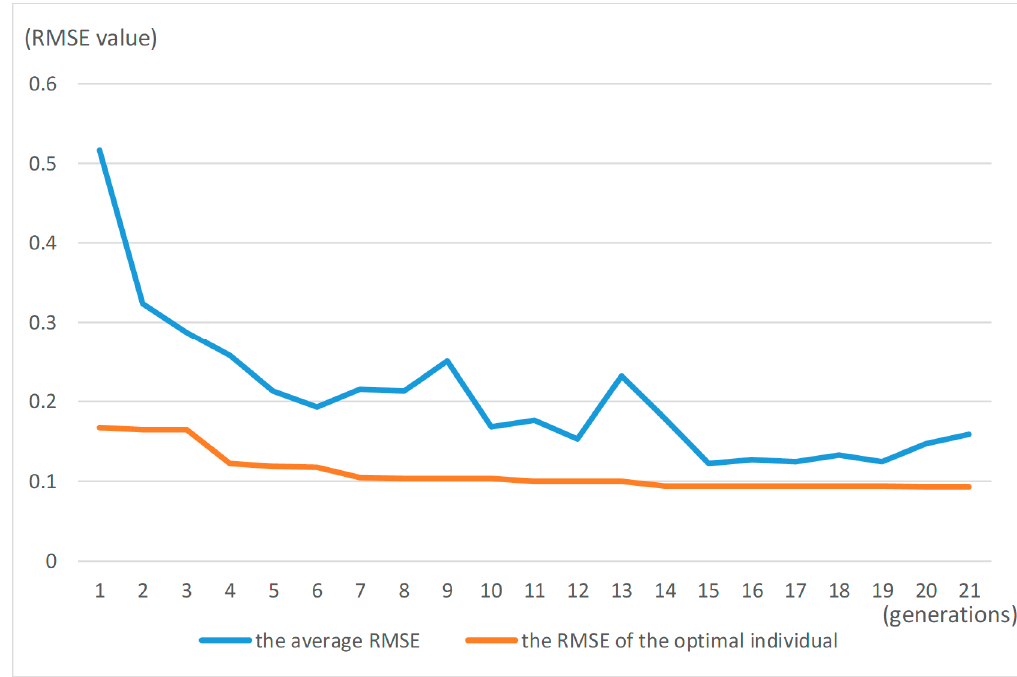
Figure 5. The root mean square error (RMSE) curve of the optimal individual and the average in the population. Table 6. The RMSE value of the optimal individual and the average in the population. Number of generations.